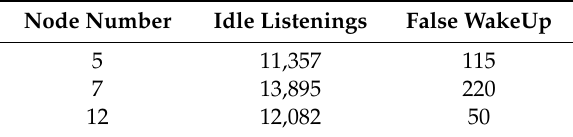
Table 5. Number of idle listenings and false WakeUps in nodes 5, 7, and